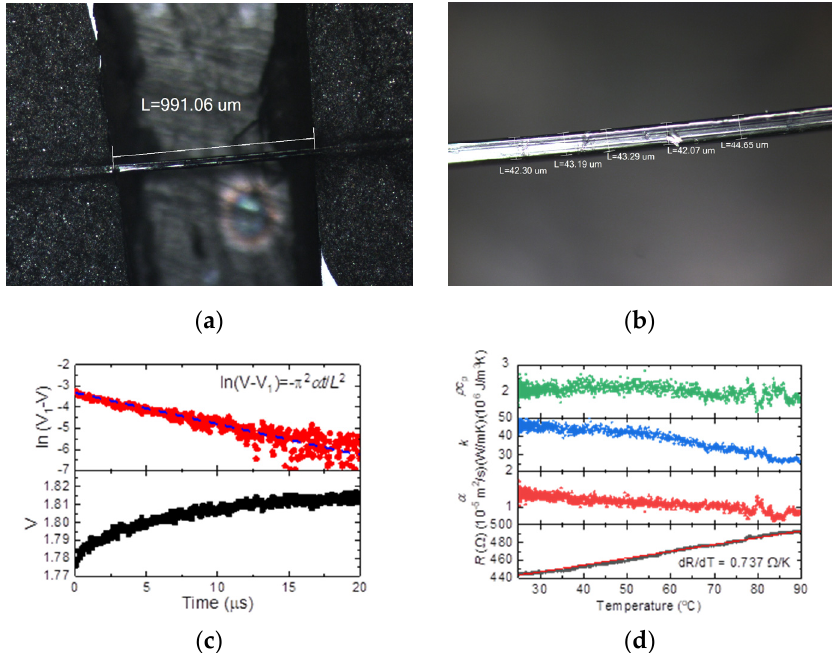
Figure 3. Verification of the method by using a UHMW-PE fiber. ( a ) Length and ( b ) width of the sample UHMW-PE fiber. ( c ) A typical measured voltage variation (bottom) and thermal diffusivity determination (top). ( d ) The variations of thermal diffusivity α , thermal conductivity k , volumetric heat capacity ρ ∙ c p , and electrical resistance R for the UHMW-PE fiber against temperature.